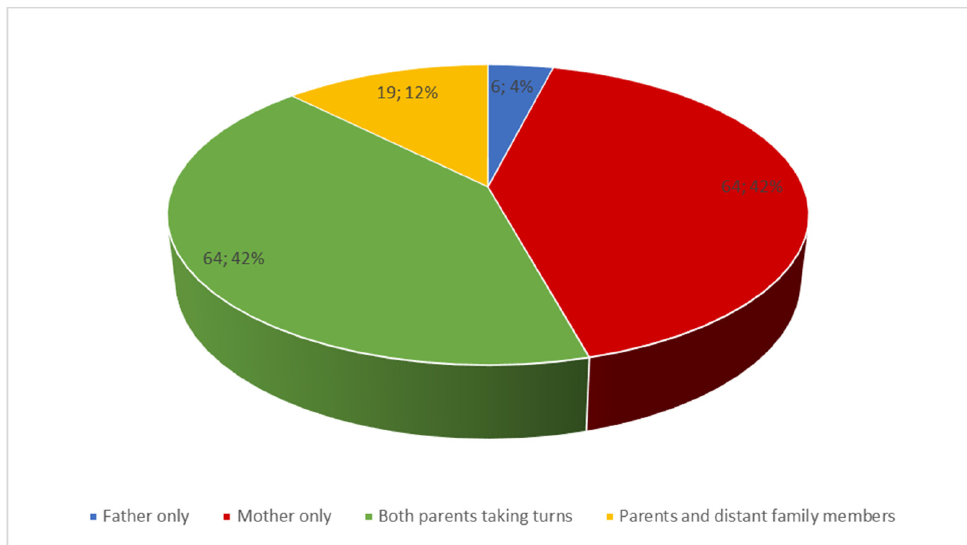
Figure 3. Care of the child during hospitalization.